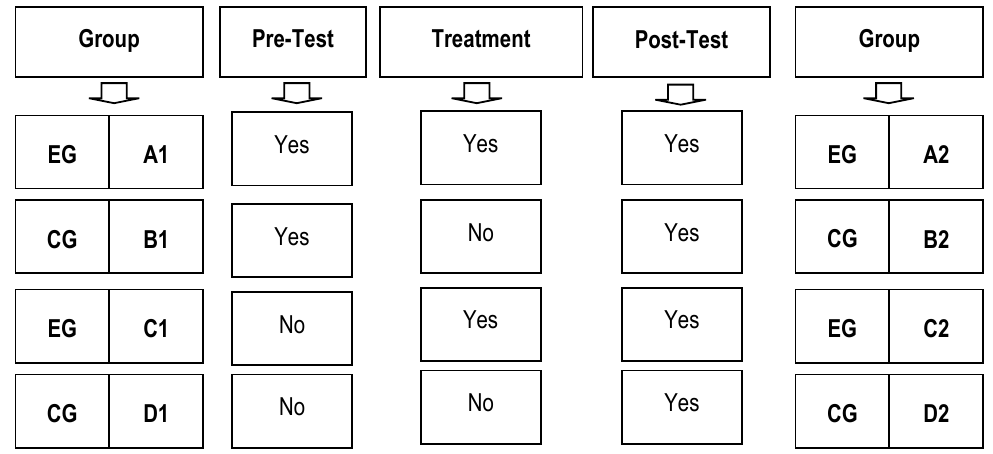
Figure 2. Quasi-Experimental Design of REBT with Patronage